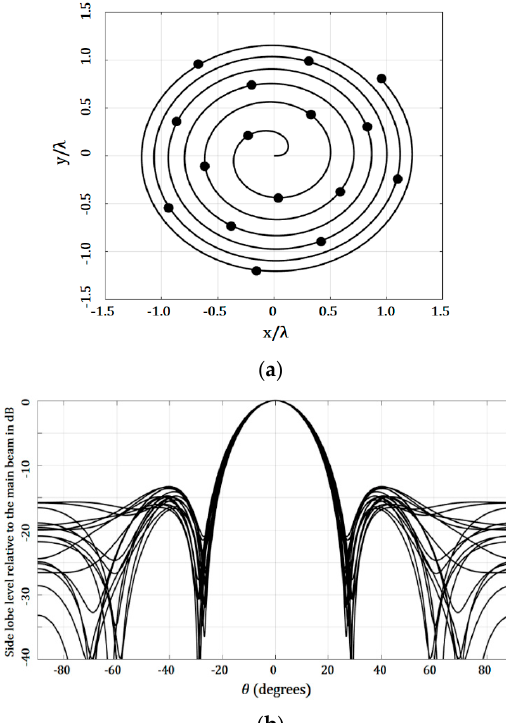
Figure 5. Results for the design case using the golden angle (uniform amplitude excitation): ( a ) ge- ometry generated and ( b ) array factor.